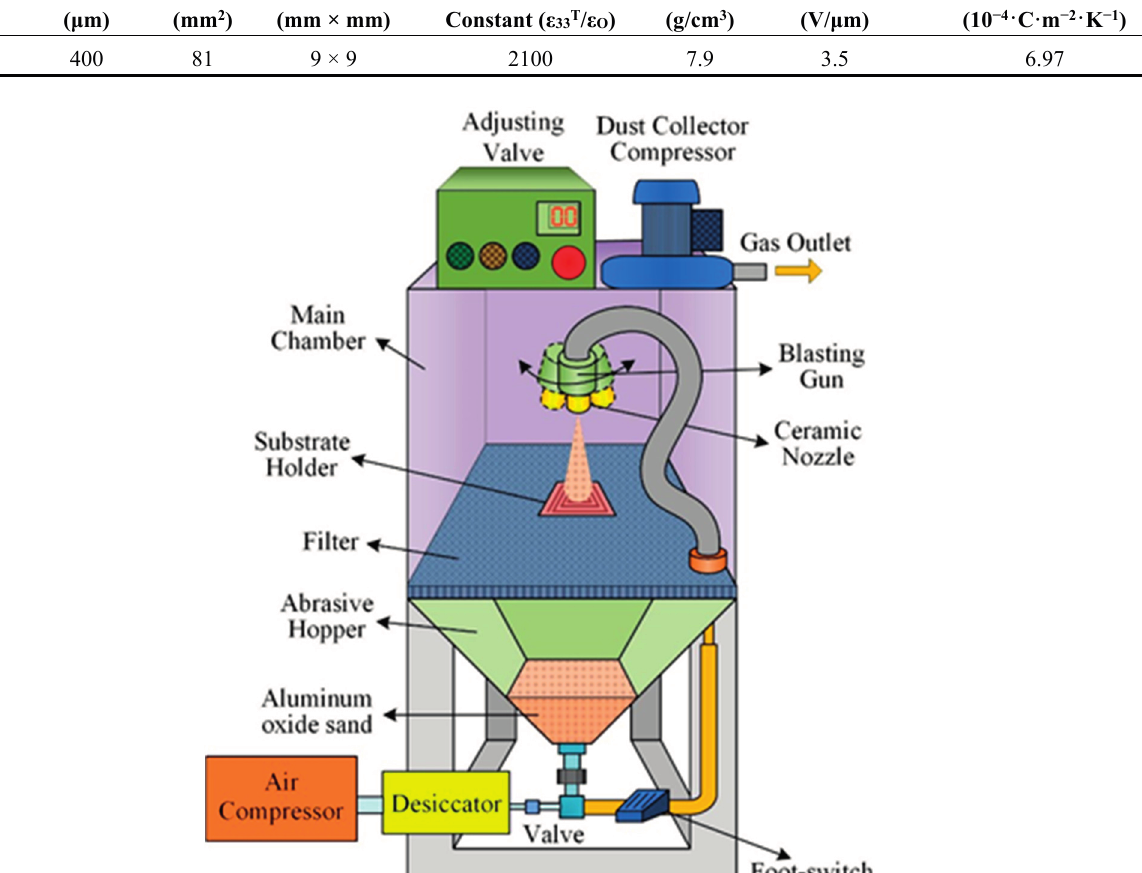
Figure 1. Schematic diagram of the sandblast etching